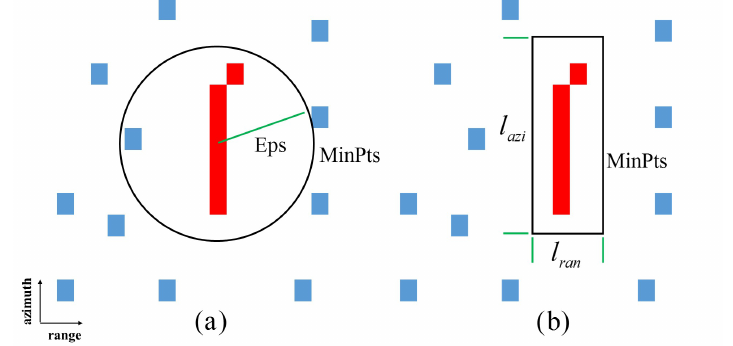
Figure 10. The ( a , b ) are illustration of conventional and modified DBSCAN method